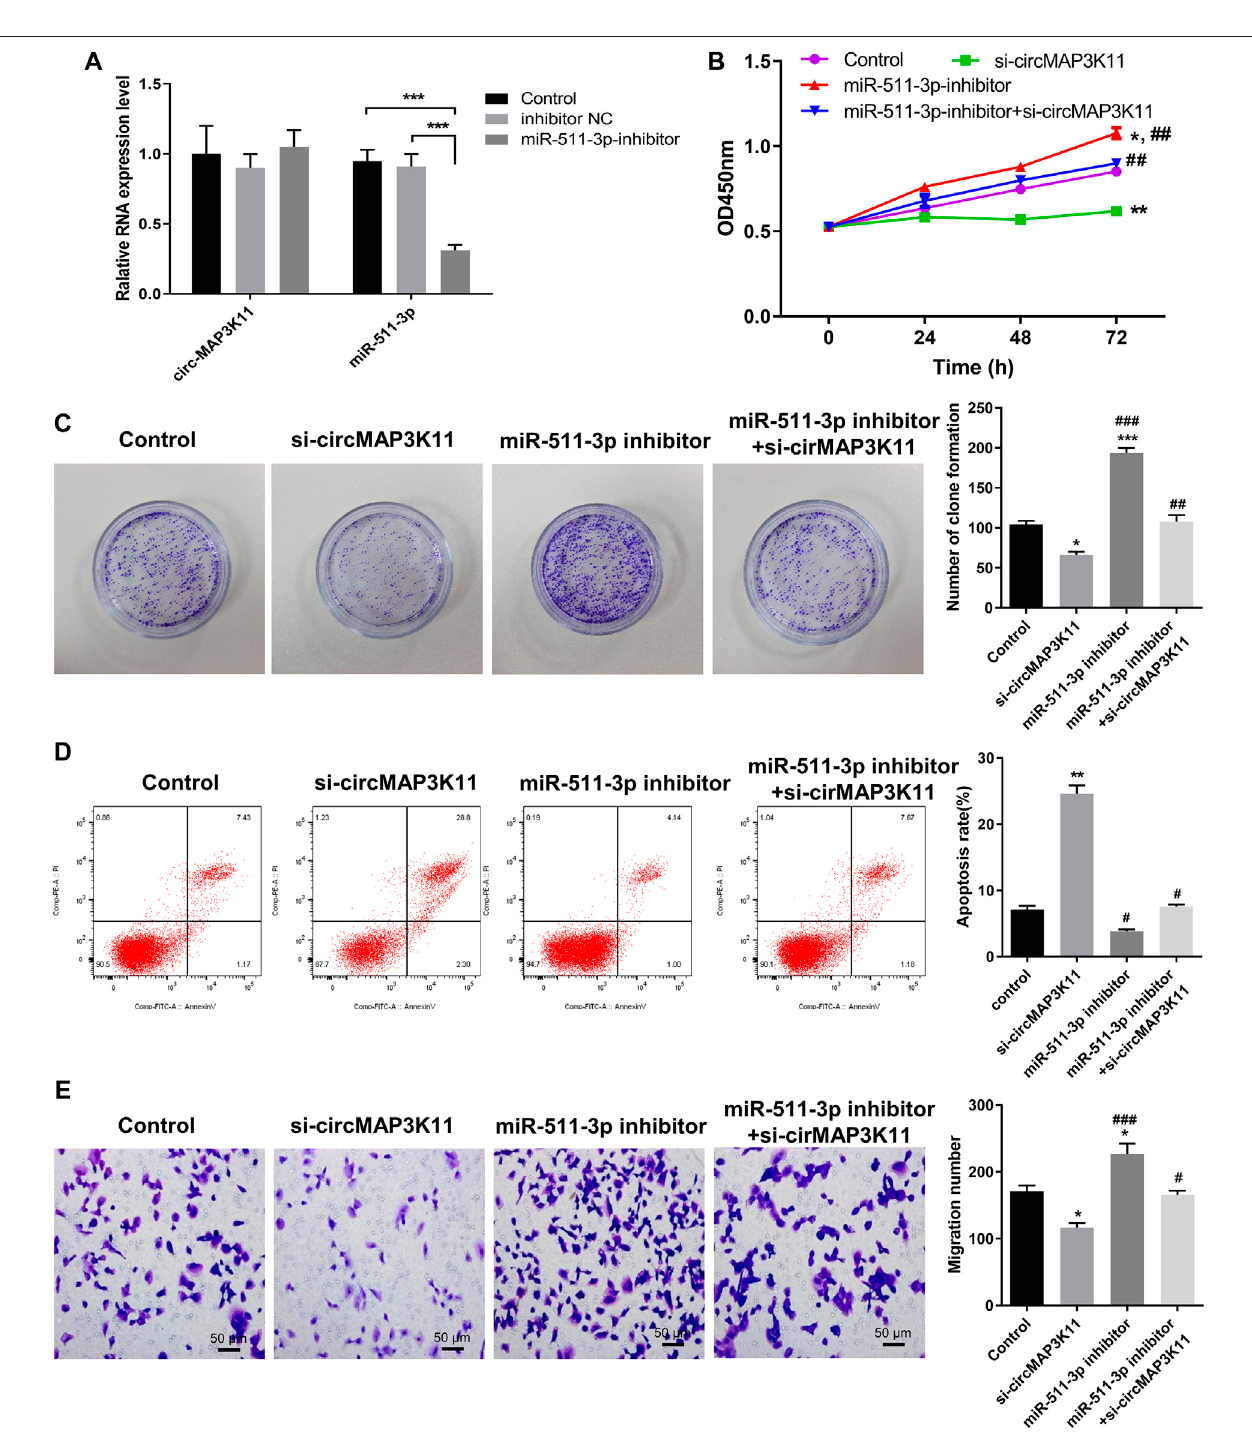
FIGURE 3 | Silencing circMAP3K11 (si-circMAP3K11) antagonizes the effects of miR-511-3p inhibitor on cell viability, proliferation, apoptosis, and migration in PDLSCs (A) The expression of circMAP3K11 and miR-511-3p in PDLSCs transfected with miR-511-3p inhibitor and corresponding control was detected by RT-PCR (B) The cell viability (C) proliferation (D) cell apoptosis, and (E) migration ability of PDLSCs in which circMAP3K11, miR-511-3p inhibitor, or both, were repressed, were evaluatedbyMTT,colonyformation,FCM, andtranswellassays,respectively.Note: * p < 0.05,** p < 0.01,and*** p < 0.005,vs.control;# p < 0.05,## p < 0.01,and ### p < 0.005, vs. miR-511-3p